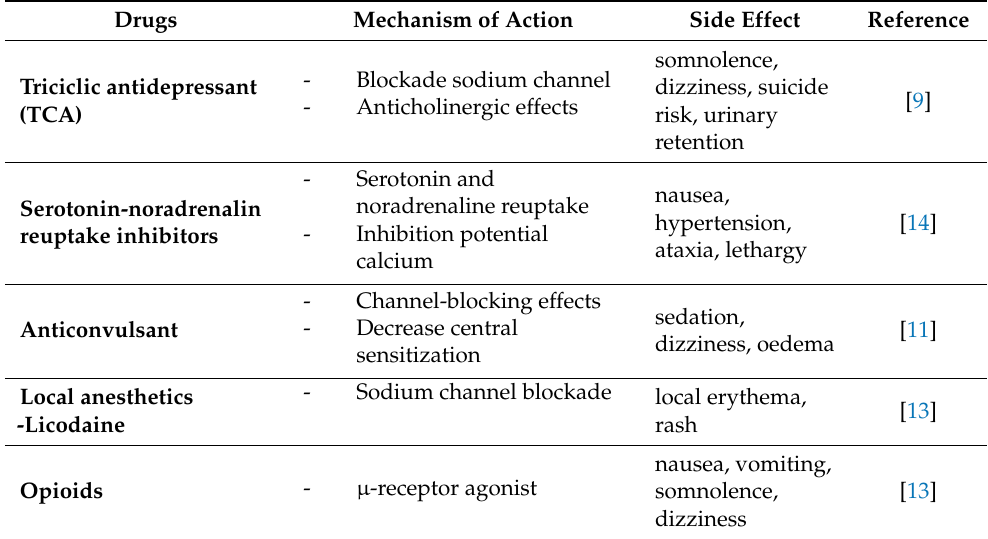
Table 1. Pharmacological treatment in neuropathic